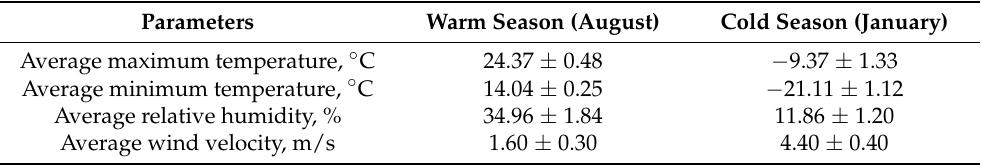
Table 1. Climatological data during the warm and cold